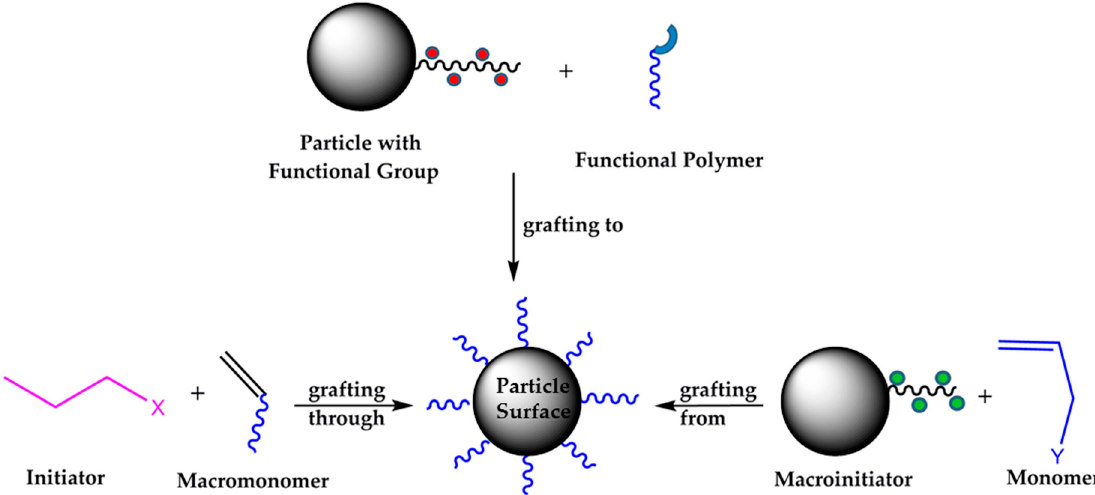
Figure 1. Three main strategies for grafting polymers on solid surfaces: Grafting to, grafting through, and grafting from. The terminal double bond, one typical polymerization unit, is drawn.